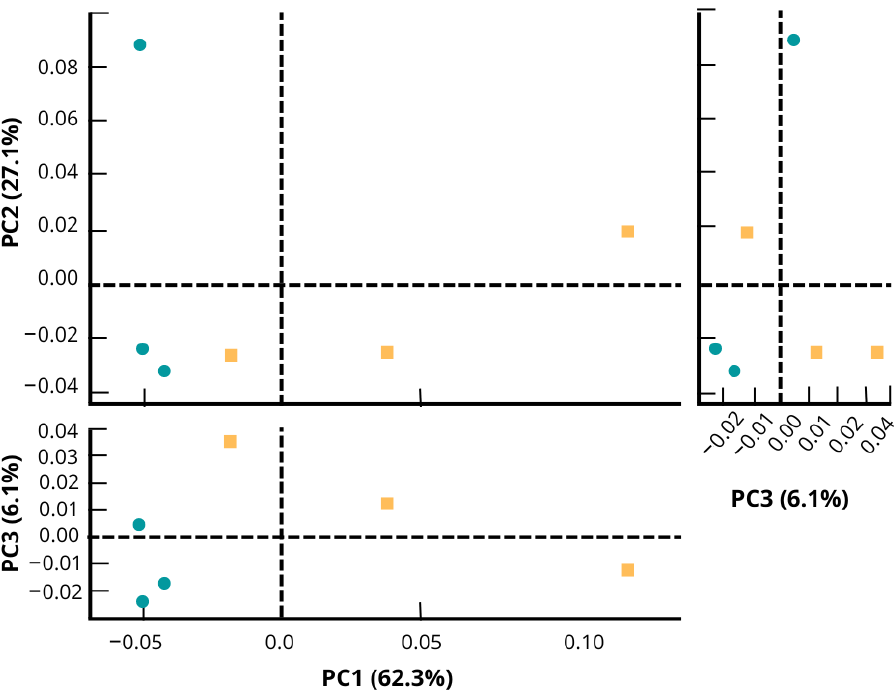
Figure 3. Principal component analysis representing the structure of the bacterial community of soil microcosm under application of fipronil and control at the genus level. The PCA was generated using the software STAMP. Control samples are plotted in green color and fipronil in yellow color. Each axis shows the variance explained in percentage of the distance between the bacterial community structures of the